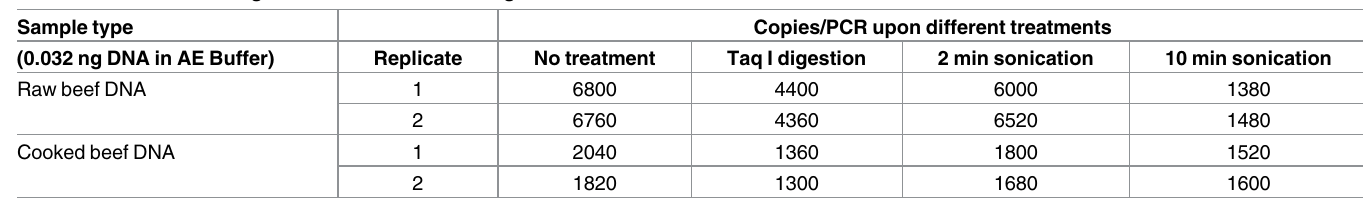
Table 3. Effect of DNA degradation on ddPCR